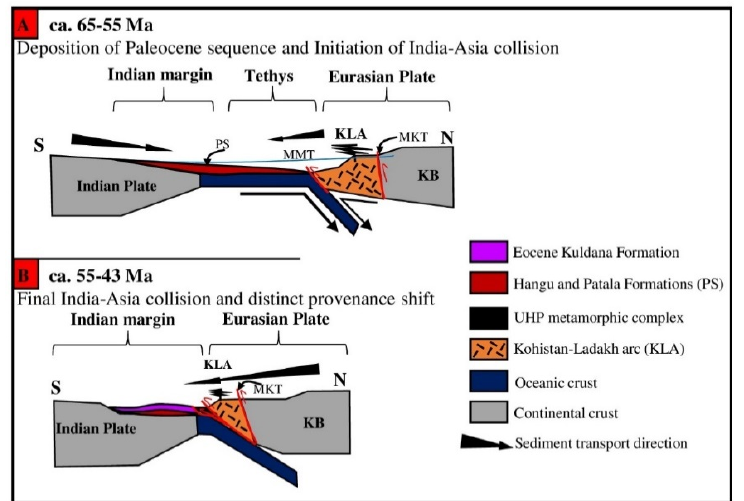
Figure 6. Tectonic model explaining the provenance change and India–Asia collision in the northwestern (NW) Himalayas (modified after Ding et al., [16]). ( A ) Deposition of the Paleocene sequence and initiation of the India–Asia collision. ( B ) Final India–Asia collision and subsequent exhumation of the KLA and associated blocks indicating major provenance shift from south to north.